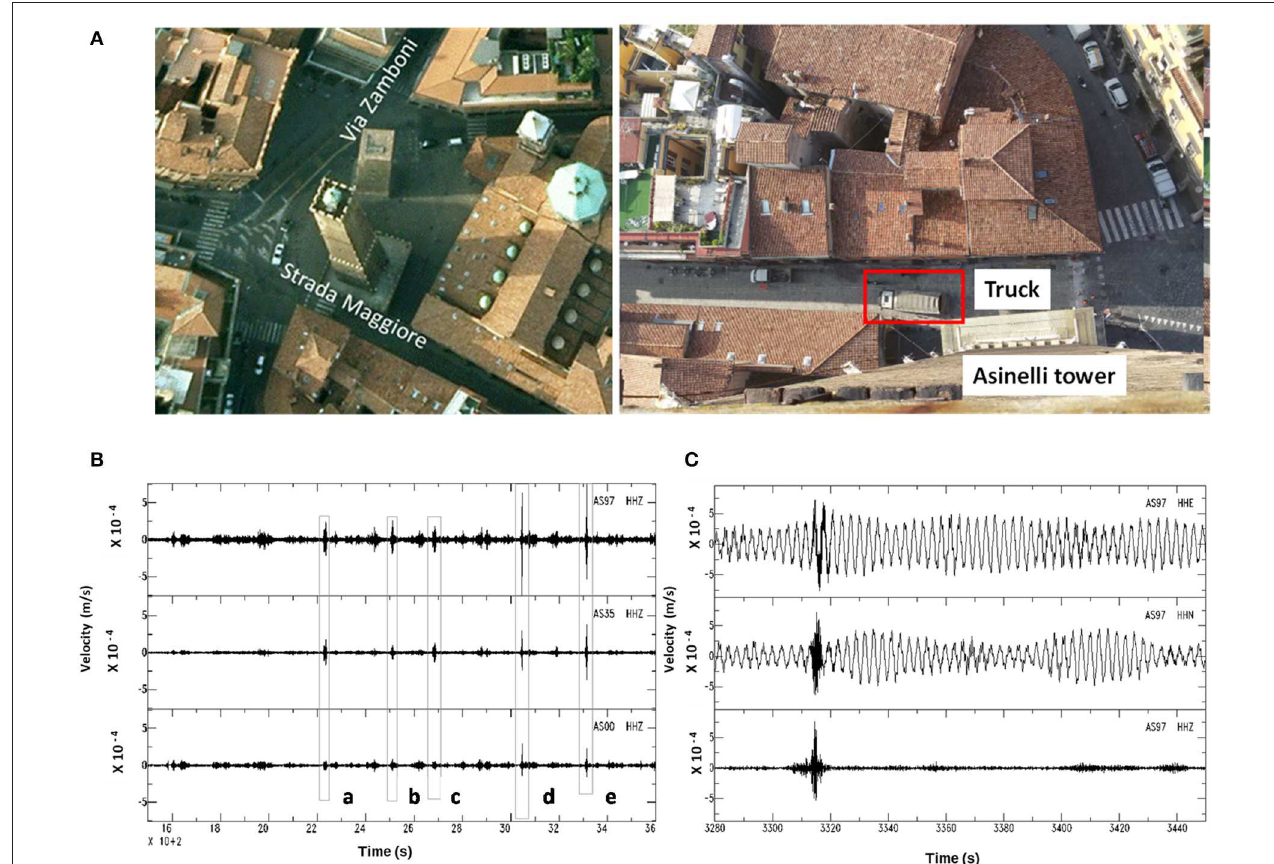
FIGURE 10 | (A) On the left, view of the position of the Two Towers (Google Earth) and on the right, picture of the transit of a truck along Strada Maggiore during the experimental measurements. (B) Vertical component waveforms recorded at the three measurement points during the five passages of the truck. (C) Waveforms recorded during the most energetic test (E) at the top level station, from top to down, respectively, EW, NS, and Z